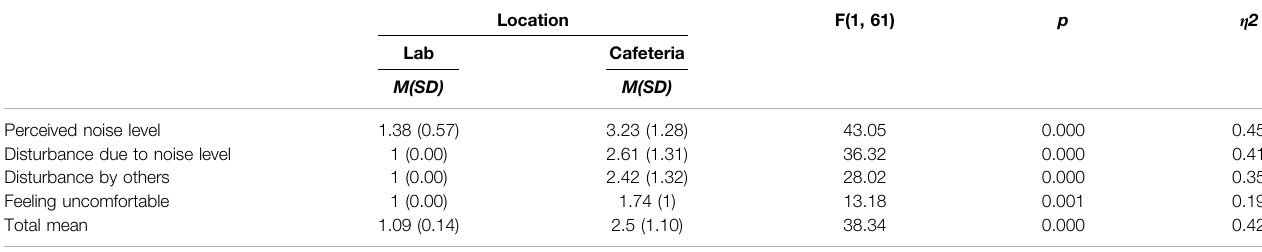
TABLE 2 | Results for disturbance items.